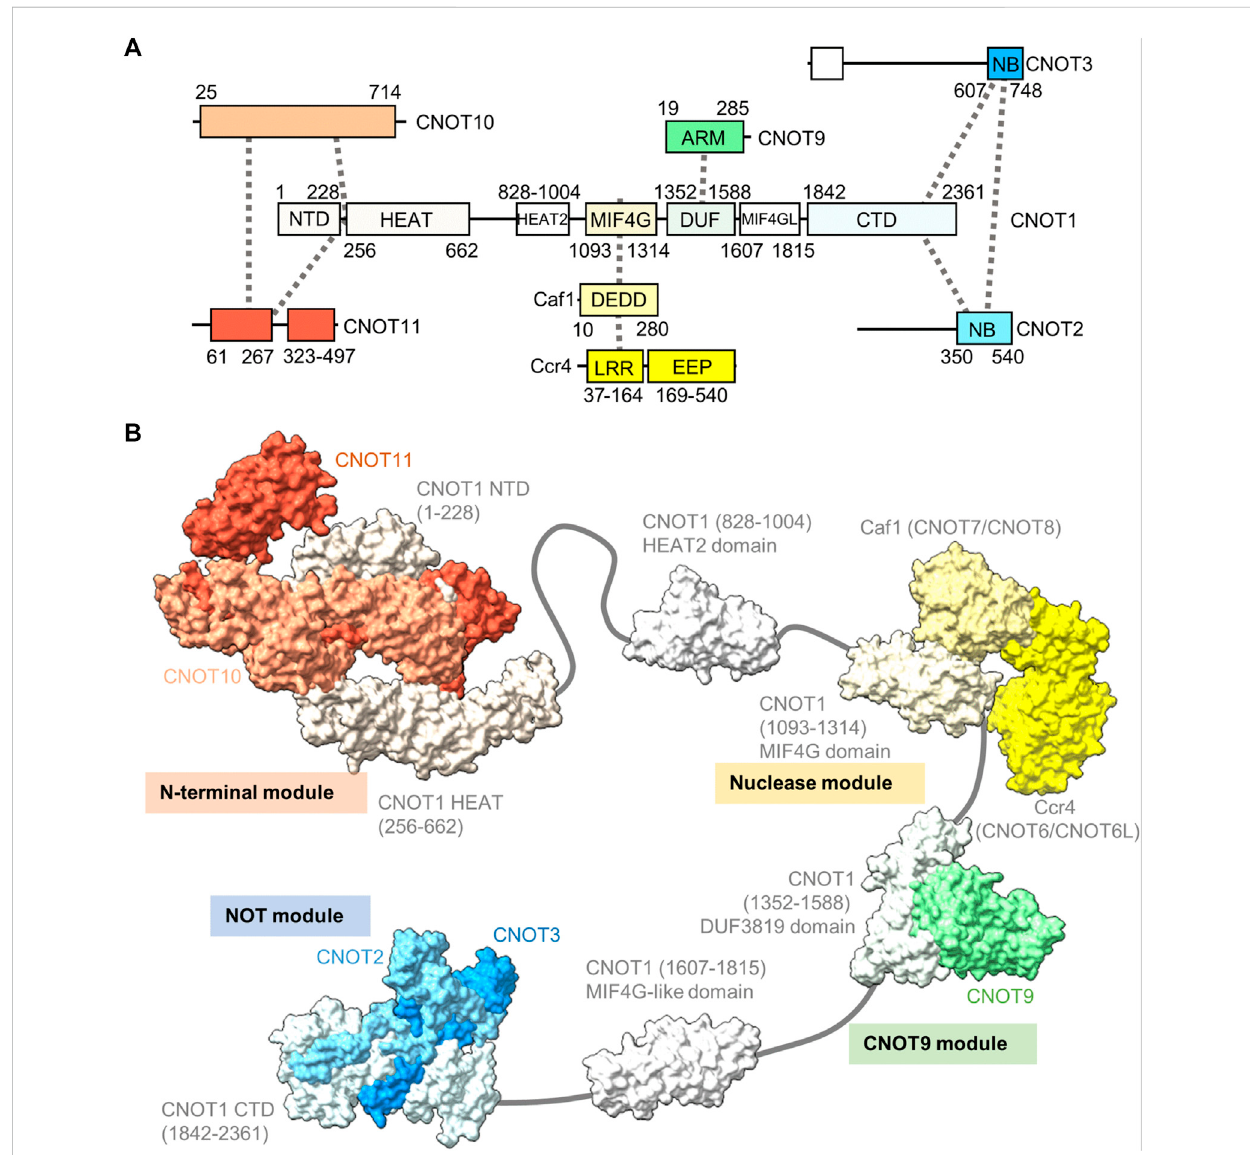
FIGURE 2 Structure of the Ccr4-Not complex. (A) Overview of the architecture of the Ccr4-Not complex. Indicated are the subunits and conserved domains. Interactions are indicated using dotted lines. The colours represent functional modules. (B) Structure of thehuman Ccr4-Not complex. Indicated are the N-terminal module composed of the N-terminal region of CNOT1, CNOT10 (light orange) and CNOT11 (dark orange) (PDB entry: 8BFI) (Mauxion et al., 2022), MIF4G-like domain 1 of CNOT1 (PDB entry:4J8S) (Fabian et al., 2013), the nuclease module composed of the CNOT1 MIF4G domain, Caf1/ CNOT7 (light yellow) and Ccr4/CNOT6L (dark yellow) (PDB entries 3NGQ and 7VOI) (Wang et al., 2010; Zhang et al., 2022), the CNOT9 module (PDB entry: 4 − ΔΔ CT 6 or 4CRV) (Chen et al., 2014; Mathys et al., 2014) composed of the DUF3819 domain of CNOT1 and CNOT9 (green), a second MIF4G-like domain of CNOT1 (modelled on the structure of the Chaetomium thermophilum fragment, PDB entry 6H3Z) (Raisch et al., 2018), and the NOT module composedoftheCNOT1C-terminaldomainandtheconservedNOT-BoxregionslocatedattheC-terminiofCNOT2(lightblue)andCNOT3(blue)(PDB entry: 4C0D) (Boland et al., 2013). Numbers in brackets refer to the amino acid residues of